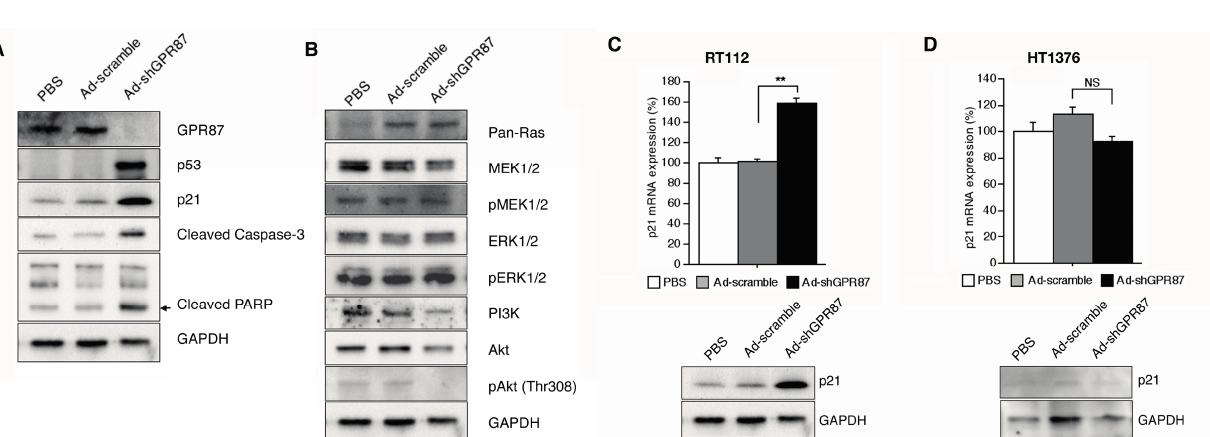
Figure 5. Flow cytometric analysis of propidium iodide-staining in GPR87-overexpressing RT112 cells 5 days after infection with Ad-shGPR87 at a MOI of 20. Apoptotic cells were represented by the fraction of cells in the sub-G1 phase. The apoptotic cells in the Ad-shGPR87-treated group ( C ) were significantly increased compared to the PBS-treated ( A ) and Ad-scramble-treated group ( B ). One of three experiments with similar results is shown.